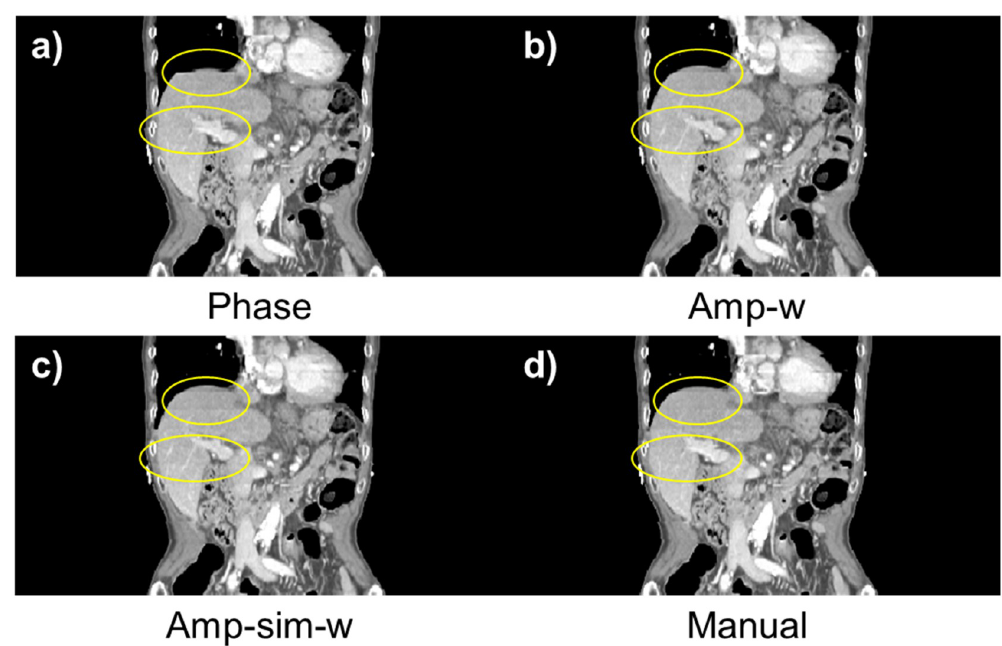
Fig 14. Coronal view of sorted 4DCT of the abdominal region according to the sorting algorithm. (Patient #1) (a) conventional phase sorting, b) amplitude-weighted phase sorting, c) amplitude-weighted phase sorting with image similarity, and d) manual sorting method.